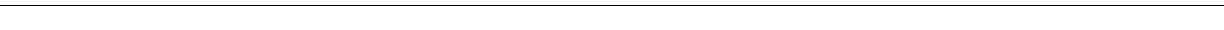
Figure 4 | IFN c -resistant melanoma evolves into a T-cell-resistant lesion. ( a ) Mutation defined by targeted sequencing on DNA from Ma-Mel-61h cells and autologous blood cells as wild-type (WT) control (ctrl). Plots of aligned sequencing reads in the location where the JAK1 c.1798G 4 T, p.G600W mutation was identified. WTsequence shown on the bottom, arrow highlights mutation or corresponding wild-type (WT) site. Number of sequencing reads notated on the left; %, frequency of mutations in reads. ( b ) Lysates from IFN g -treated (48h) Ma-Mel-61b, Ma-Mel-61g and Ma-Mel-61h cells analysed by western blot for expression of IRF1 and HLA class I heavy chains; GAPDH, loading control. Representative data from n ¼ 3 independent experiments. ( c ) HLA class I and CD54 surface expression on IFN g -treated (48h) Ma-Mel-61g and Ma-Mel-61h cells, measured by flow cytometry. Representative data from n ¼ 3 independent experiments. ( d ) Immunohistochemical staining of serial cryostat tissue sections from metastasis Ma-Mel-61g for melanoma marker HMB45 and HLA class I. ( e ) Ma-Mel-61h and Ma-Mel-61g cells, transfected with expression plasmids encoding wild-type JAK1 or mutant JAK1-G600W, analysed for specific mRNA expression by quantitative reverse transcription–PCR in the presence of absence or IFN g (48h). Ma-Mel-61b cells served as a control (ctrl). Relative expression levels given as means ( þ s.e.m.) from n ¼ 2 independent experiments. ( f ) HLA class I surface expression on IFN g -treated (48h) Ma-Mel-61h-JAK1 and Ma-Mel-61h-JAK1-G600W transfectants, measured by flow cytometry. Representative data from n ¼ 2 independent experiments. ( g ) Ma-Mel-61h and Ma-Mel-61g cells, transfected with expression plasmids encoding wild-type JAK1 (WT) or mutant JAK1-G600W (M), analysed for recognition by autologous CD8 þ T cells in the presence or absence of IFN g (48h). T-cell activation measured as IFN g release by ELISpot assay. Representative data from n ¼ 2 independent